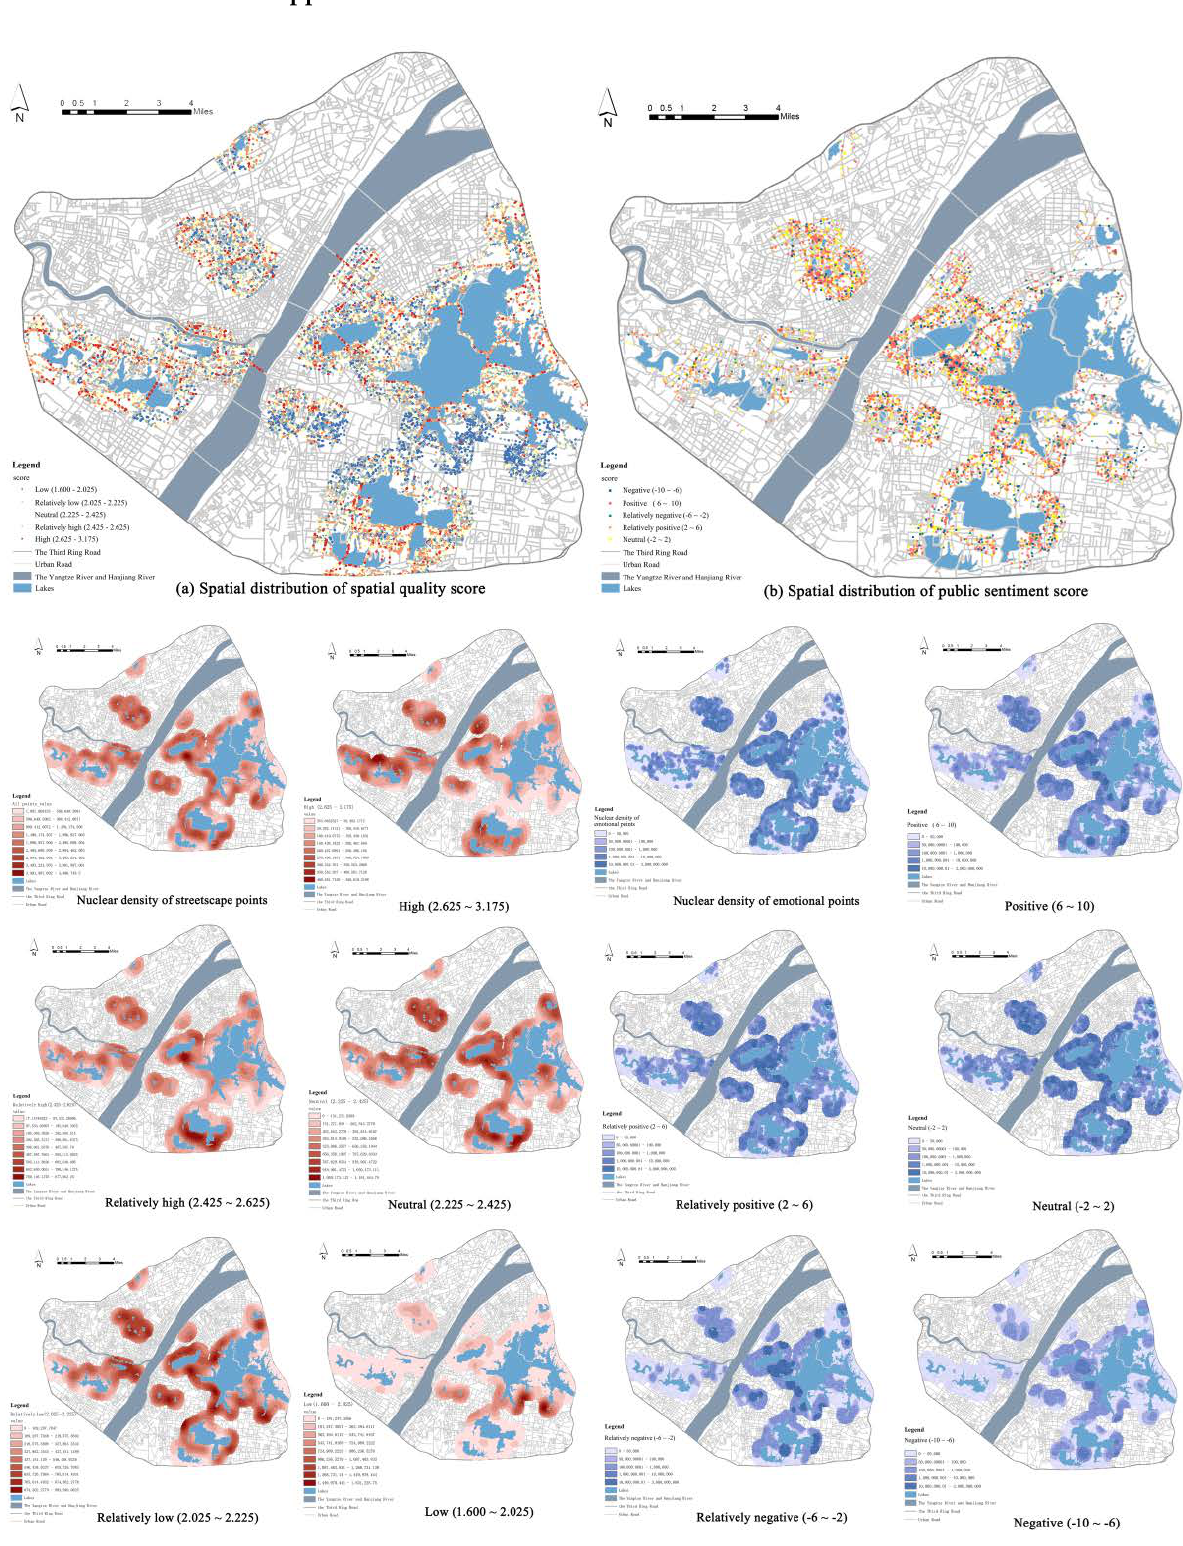
Figure A1. Spatial distribution of spatial quality and public